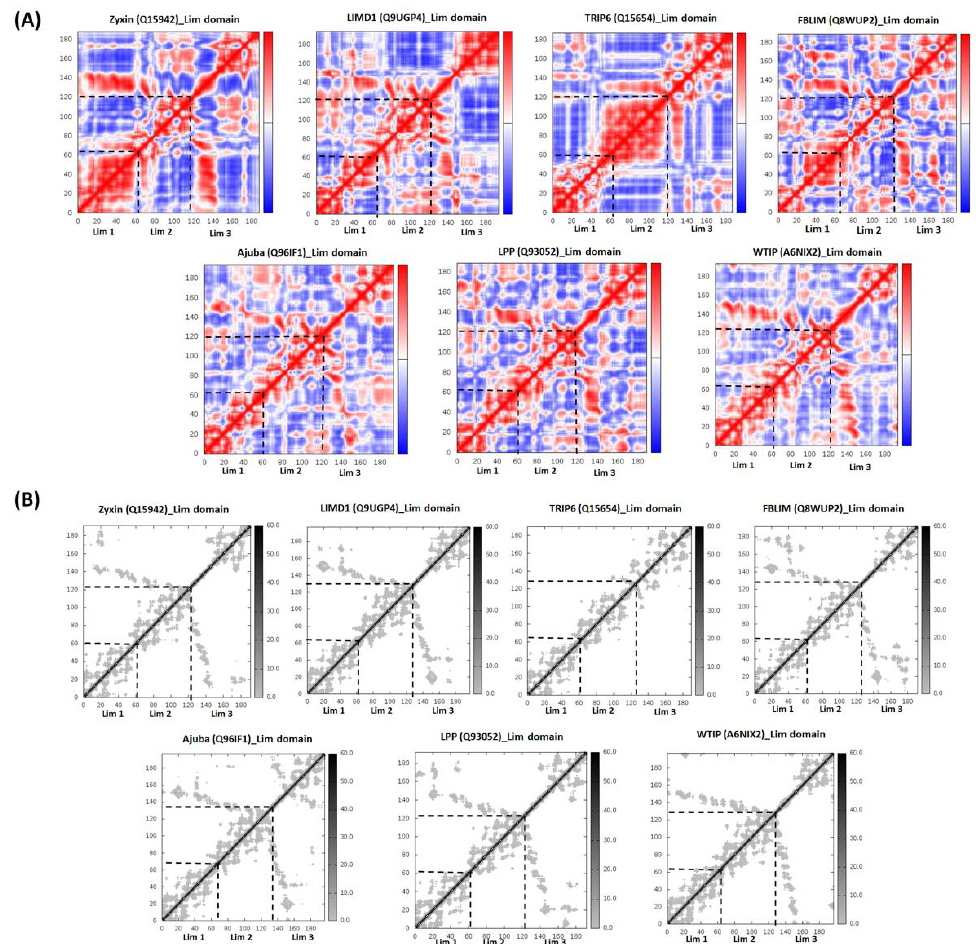
Figure 5. ( A ) Covariance analysis of the Zyxin family LIM domains. Covariance analysis was performed to understand the correlated movement of protein residues in the secondary structure which can shed light on the function of the protein. Each panel represents the covariance matrix for each member of the Zyxin family, in the matrix correlated motion is depicted as red, anti-correlated as blue, and uncorrelated as a white dot. High levels of correlated motions were observed in case of Lim1 domains of all protein proteins, varied amount of motion was observed in case of Lim2 with the highest in TRIP6, again Lim3 showed a similar kind of motion in all proteins. Proteins with similar localization and function demonstrated similarity in motion. For example, Ajuba, LIMD1, and WTIP displayed relatively similar covariance matrix of Lim3 domain these proteins are localized at the same site and constitute P-Body components, primarily perform gene regulation and mediate miRNA silencing. LPP and FBLIM1 showed similar correlated, uncorrelated and anticorrelated motions in Lim1/2/3, and both proteins involved mainly in cell shape maintenance; supporting the fact that similar dynamics may have similar localization and functions, each Lim region has its own characteristic features and believed to perform functions independently. ( B ) The linking matrix of the Elastic network model demonstrates the stiffness of the springs connecting the corresponding pair of atoms. The dots are coloured as a function of their stiffness, darker colours reflect stiffer springs. Interestingly all proteins showed a similar kind of stiffness except